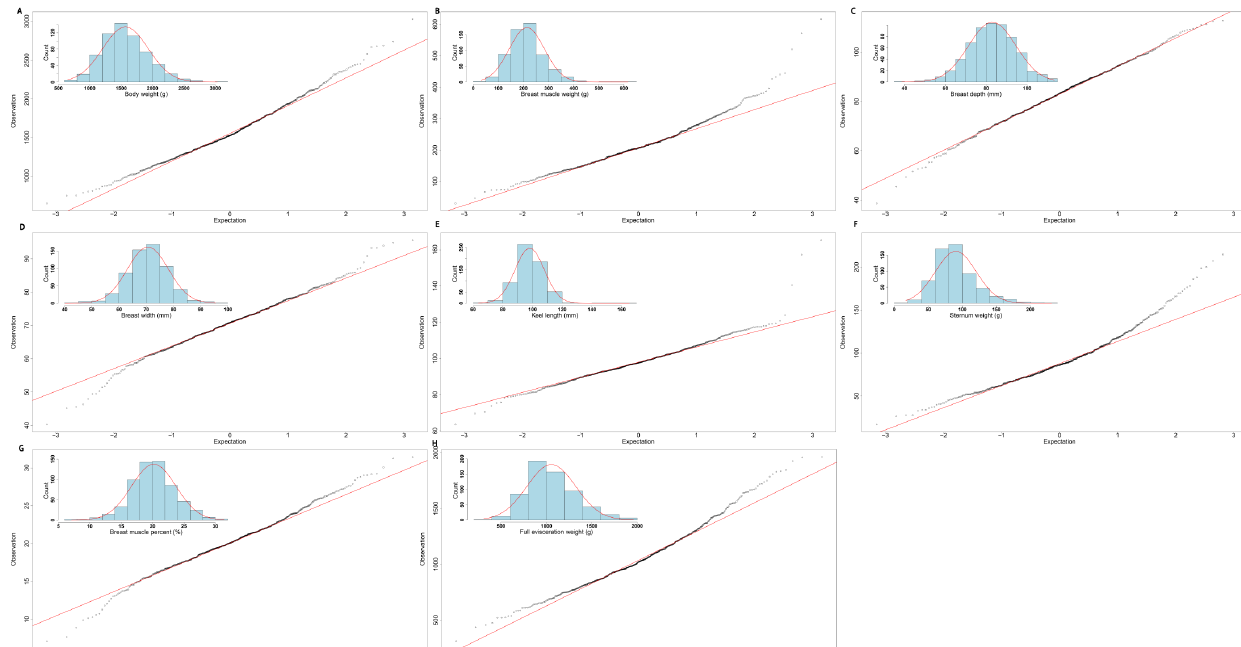
Figure 1. The normal distribution test for breast muscle development-related traits. ( A ) Body weight (g); ( B ) breast muscle weight (g); ( C ) breast depth (mm); ( D ) breast width (mm); ( E ) keel length (mm); ( F ) sternum weight (g); ( G ) breast muscle percentage (%); and ( H ) full evisceration weight